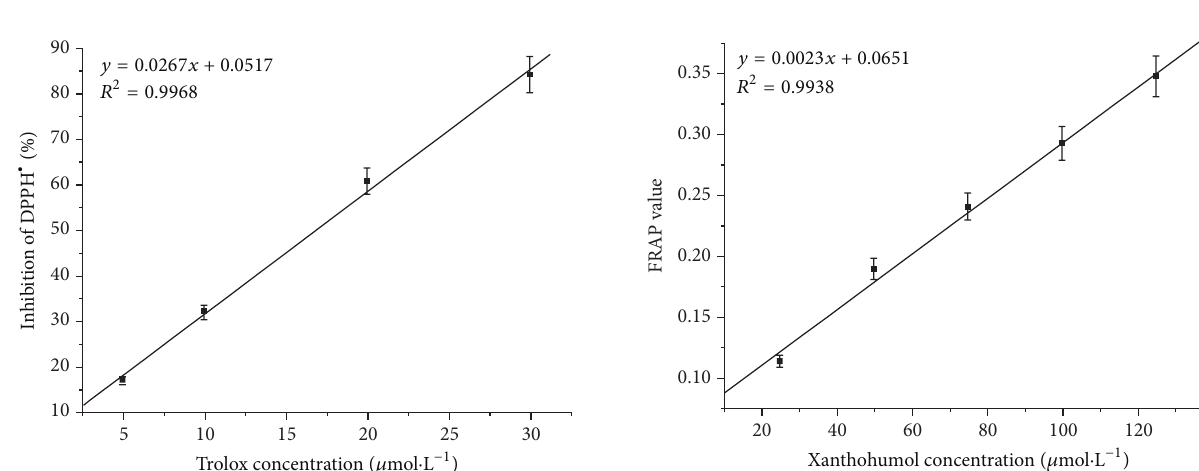
Figure 3: A linear correlation curve between Xanthohumol concen- tration and ABTS ∙+ inhibition percentage rate. 𝑌 = 0.0061𝑥+0.1298 and 𝑅 2 = 0.9821 ( 𝑛 = 3 ).